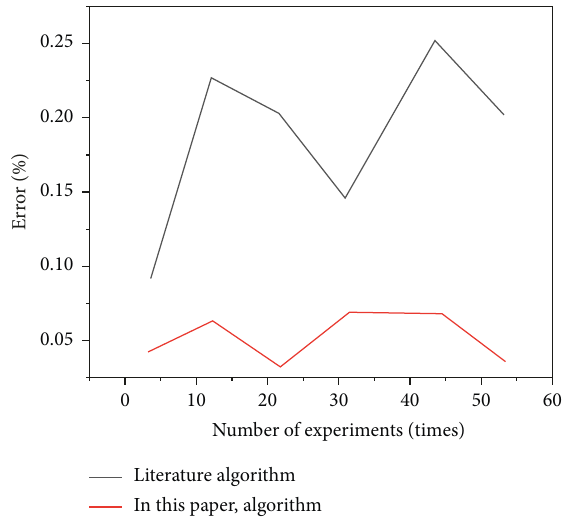
Figure 6: Comparison of modeling errors of different